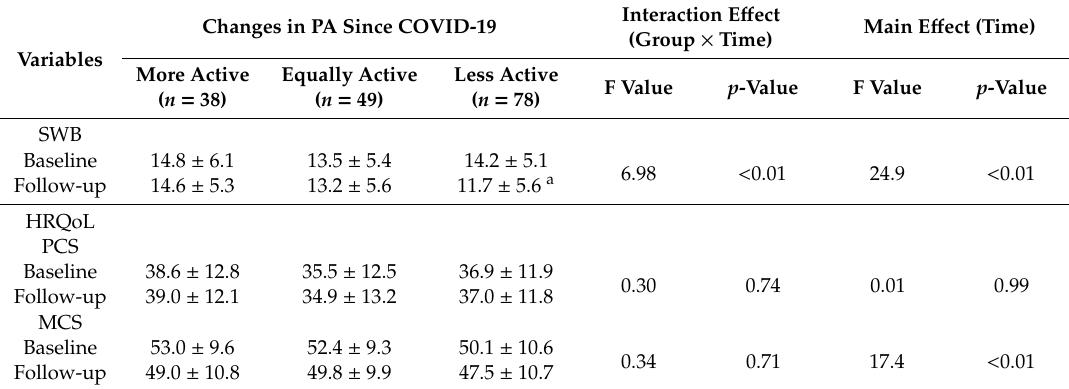
Table 2. Subjective well-being (SWB) and health-related quality of life (HRQoL) outcomes in relation to changes in physical activity (PA) since